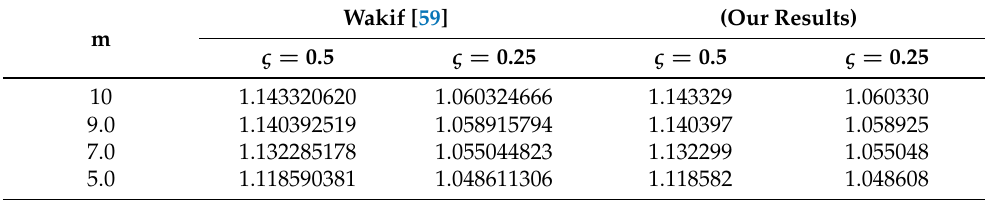
Table 1. Comparative of C fx Re